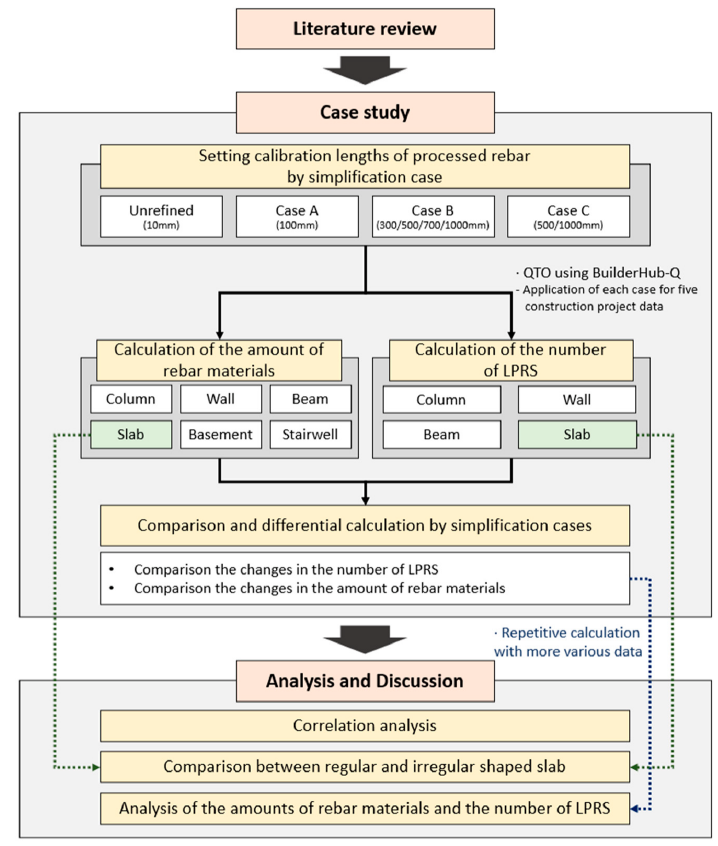
Figure 1. Research procedure of this study.